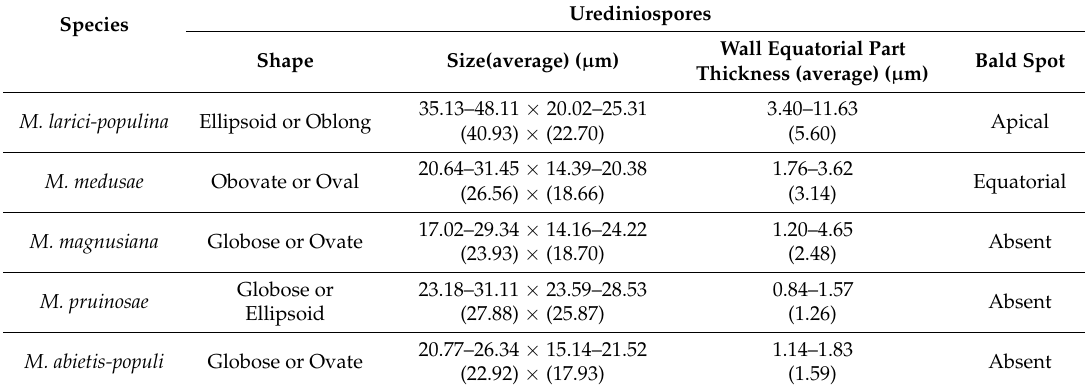
Table 3. Morphology of the five Melampsora species found on Populus in China during 2015–2018 surveys.